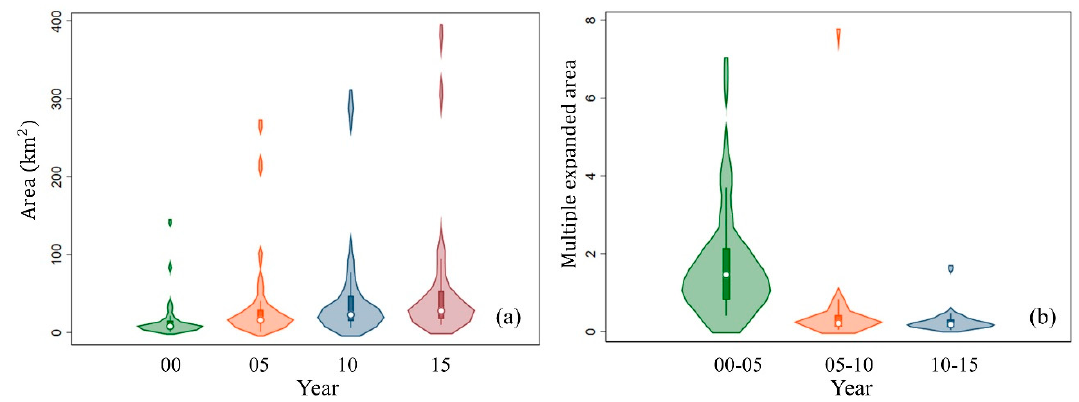
Figure 5. Statistics on the urban expansion of the 27 urban areas in the Hangzhou Bay area. ( a ) Area